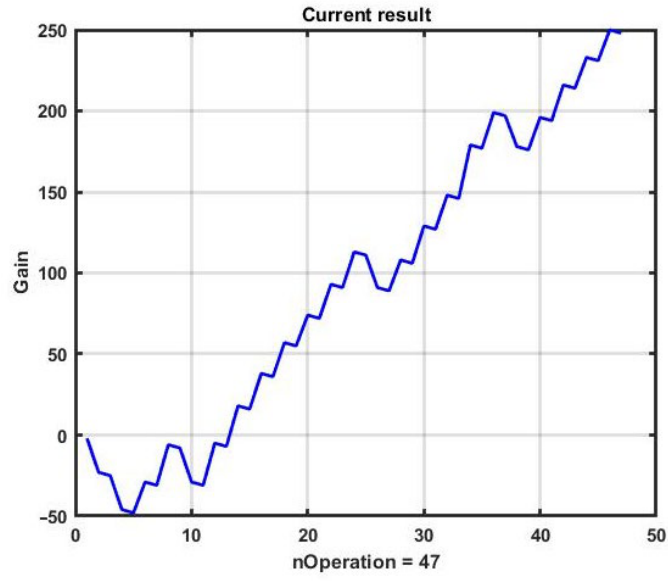
Figure 4. Performance of the CSF strategy with optimized parameters.